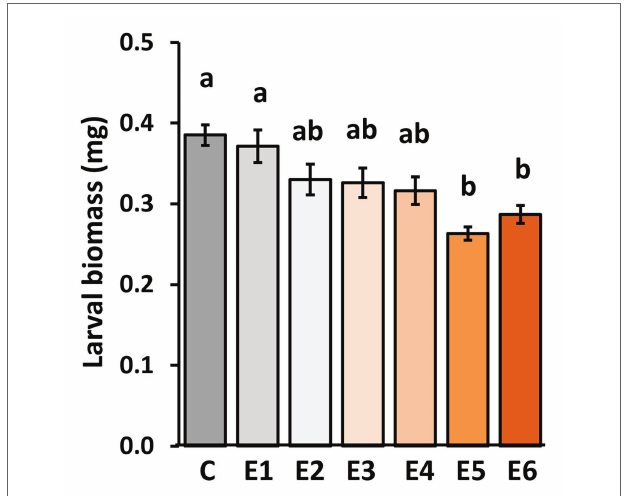
FIGURE 2 | Impact of P. brassicae egg deposition period on performance of larvae feeding on the previously egg-laden A. thaliana plants. Larval biomass of P. brassicae in mg (mean ± SE) after feeding for 48 h on egg-free A. thaliana plants control plants (C) or on plants exposed to eggs for 1 day (E1), 2 days (E2), 3 days (E3), 4 days (E4), 5 days (E5), or 6 days (E6). Different lowercase letters above the bars indicate significant differences at the level